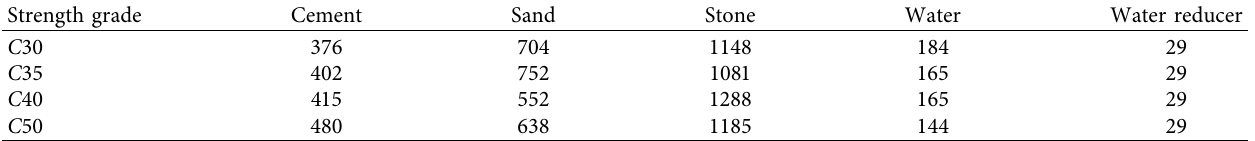
Table 3: Te mix ratio of normal concrete(kg/m 3